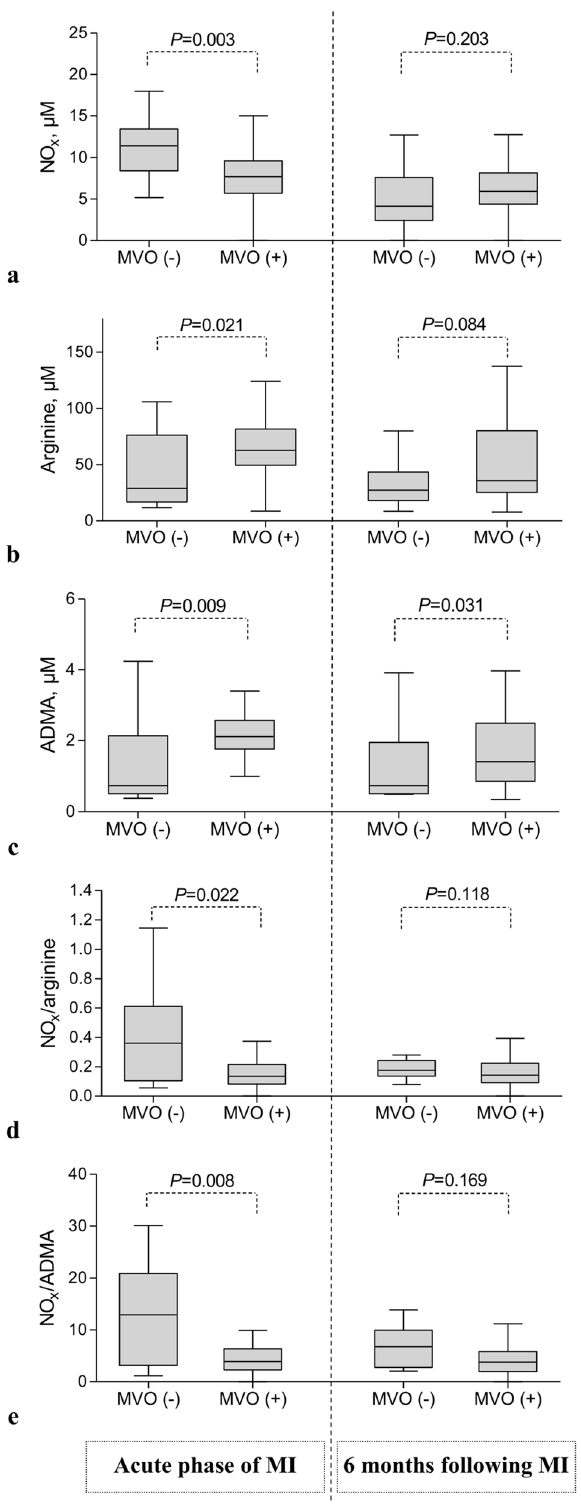
Figure 2. Arginine, ADMA, NO x and their indices in relation to microvascular obstruction. In acute phase of MI, in patients with MVO plasma level of ( a ) NO x was lower but ( b ) arginine and ( c ) ADMA concentrations were higher than in patients without MVO. ( d ) In patients with MVO, NO x /arginine and ( e ) NO x /ADMA ratios were lower than in subjects without MVO. Apart from ADMA there were no differences between patients with and without MVO at stable chronic phase. Abbreviations: Box plot shows median and interquartile range (IQR, Q3 to Q1). Q1 and Q3 are the first and third quartiles. Whiskers are drawn at minimum and maximum. MVO: microvascular obstruction present ( +) or absent ( −), ADMA: asymmetric dimethylarginine, NO x : nitrite/nitrate, MI: myocardial infarction. MVO was determined with an in-house-developed, vendor- independent, cardiac-dedicated software (CardioViewer, baseline version, Catholic University Leuven, Leuven, Belgium) 34